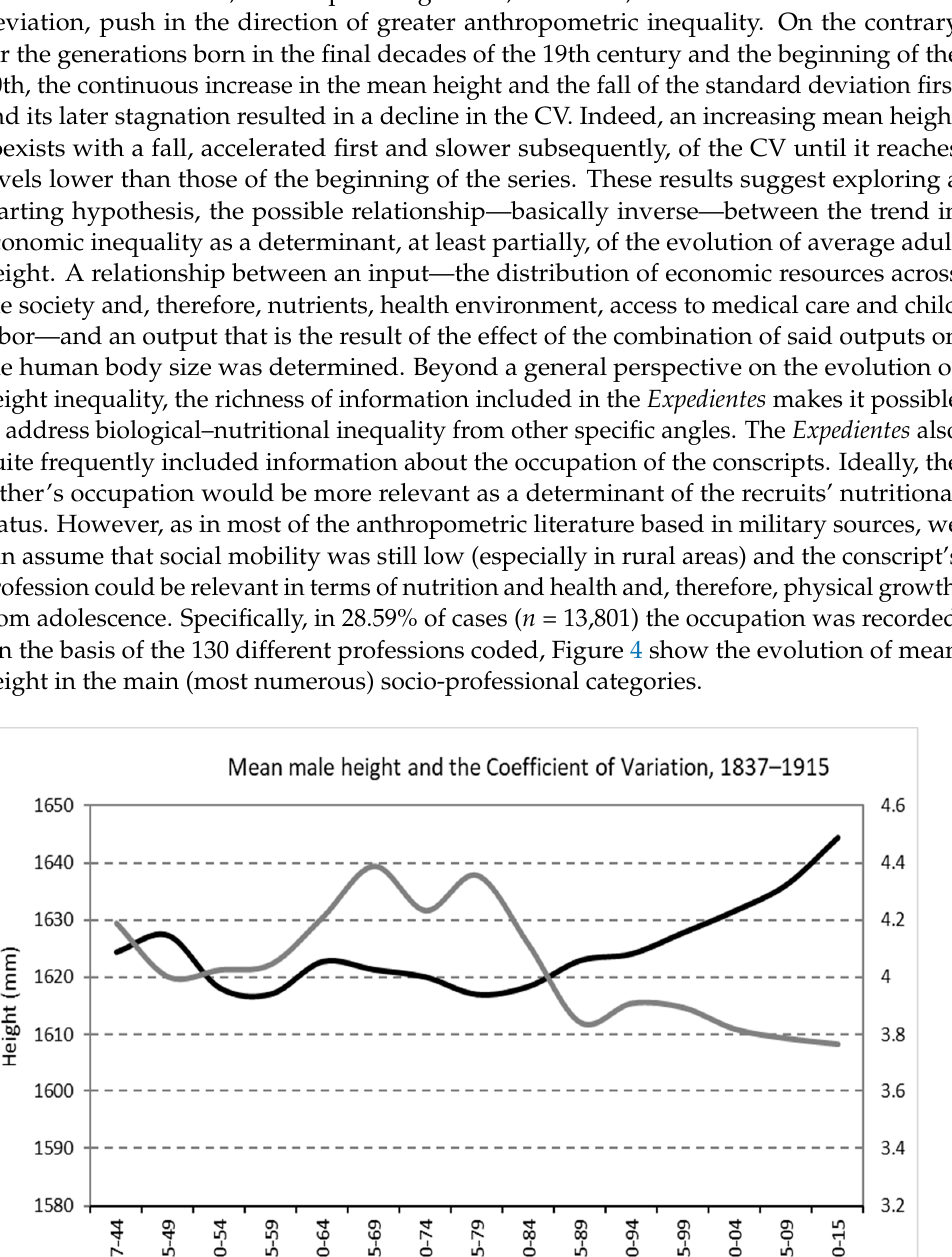
Figure 4. Average male height in the main socio-occupational groups, birth cohorts 1837–1915 (Source: calculated with data from the Expedientes ). It should be noted that all series, based on hundreds of observations for each decade (the only exception is the case of shepherds with a few dozens per decade, but always more than 30 observations per decade), share a trend of stagnation or decline in the middle decades of the 19th century, even for highly skilled service workers and students, and a subsequent positive secular trend and recovery. Second, a clear and persistent gradient